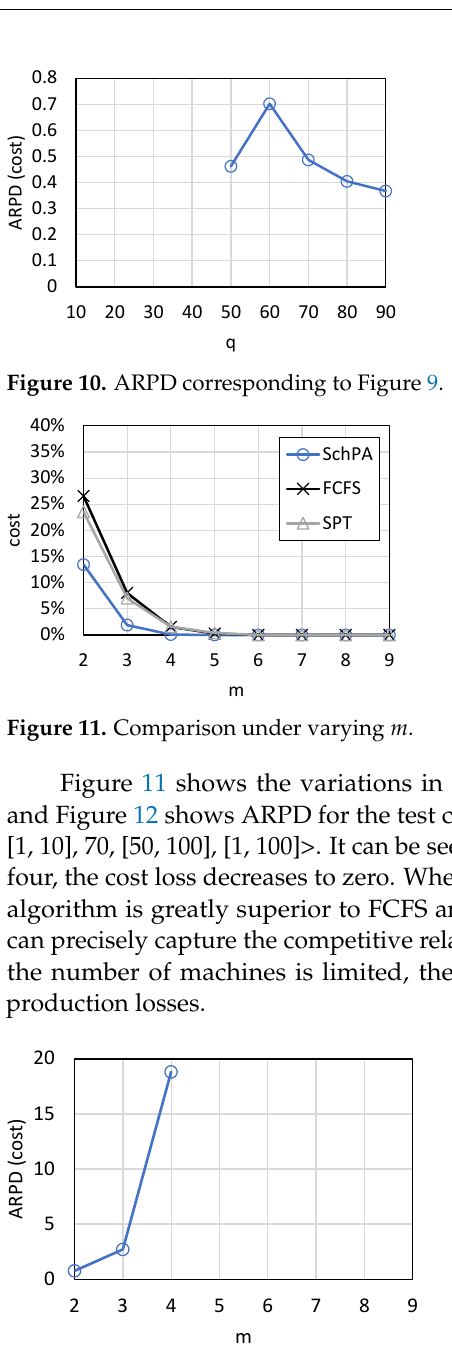
Figure 12. ARPD corresponding to Figure 11.